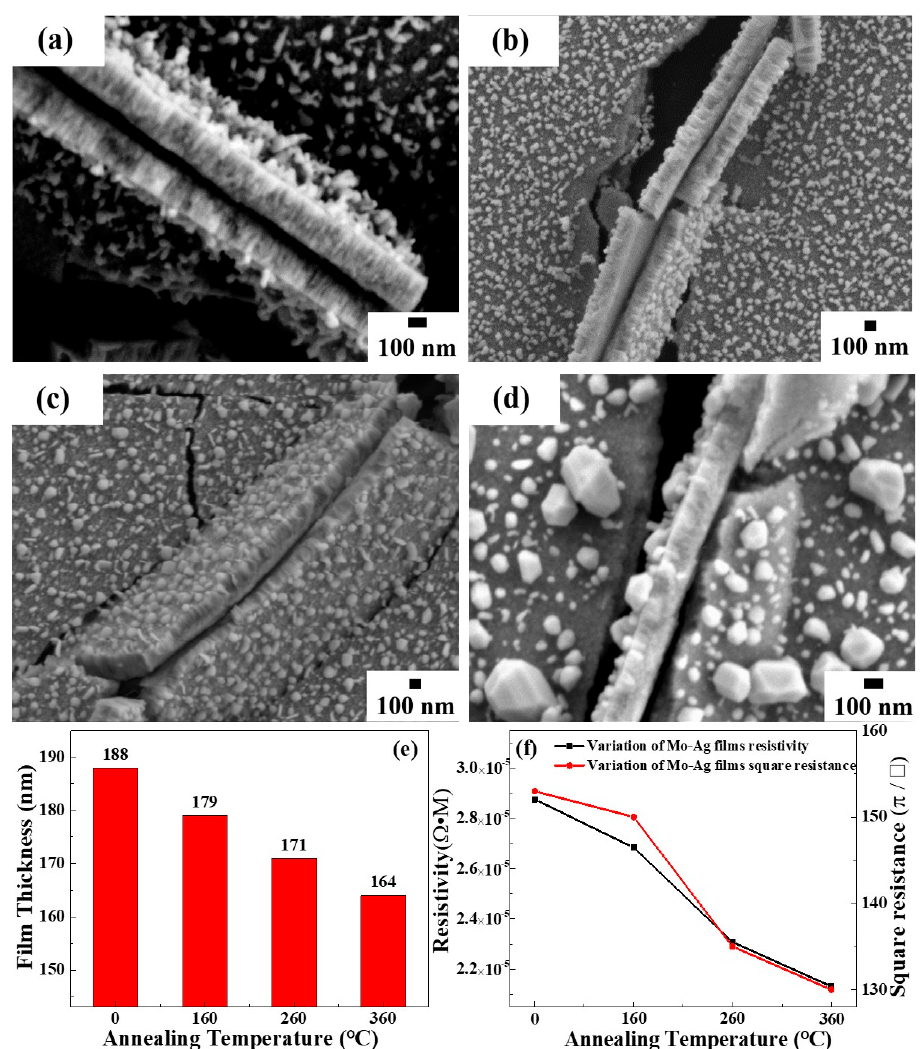
Figure 4. Cross-sectional morphology of Mo-48.2% Ag films annealed before and after annealing: ( a ) room temperature; ( b ) 160 °C; ( c ) 260 °C; ( d ) 360 °C; ( e ) variation of the film thickness with annealing temperature; ( f ) variation of square resistance and resistivity of Mo-48.2% Ag film with annealing temperature.